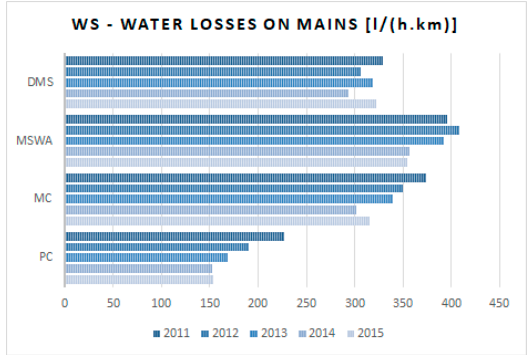
Figure 11. Evolution of water losses in the network.